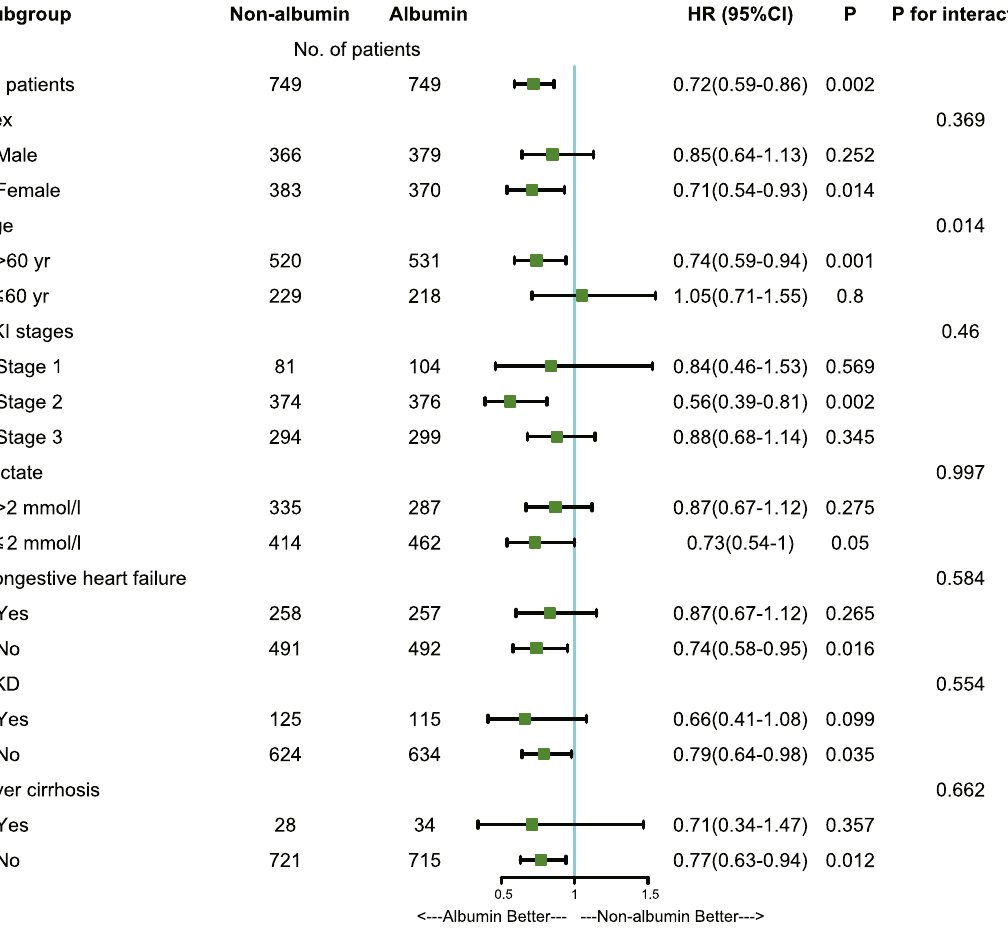
Figure 3. The association between albumin infusion and 28-day mortality in subgroups. AKI acute kidney injury; HR hazard ratio; CI confidence interval; CKD chronic kidney disease. Statistical analysis was performed using R 4.0.0 and Stata 15.1